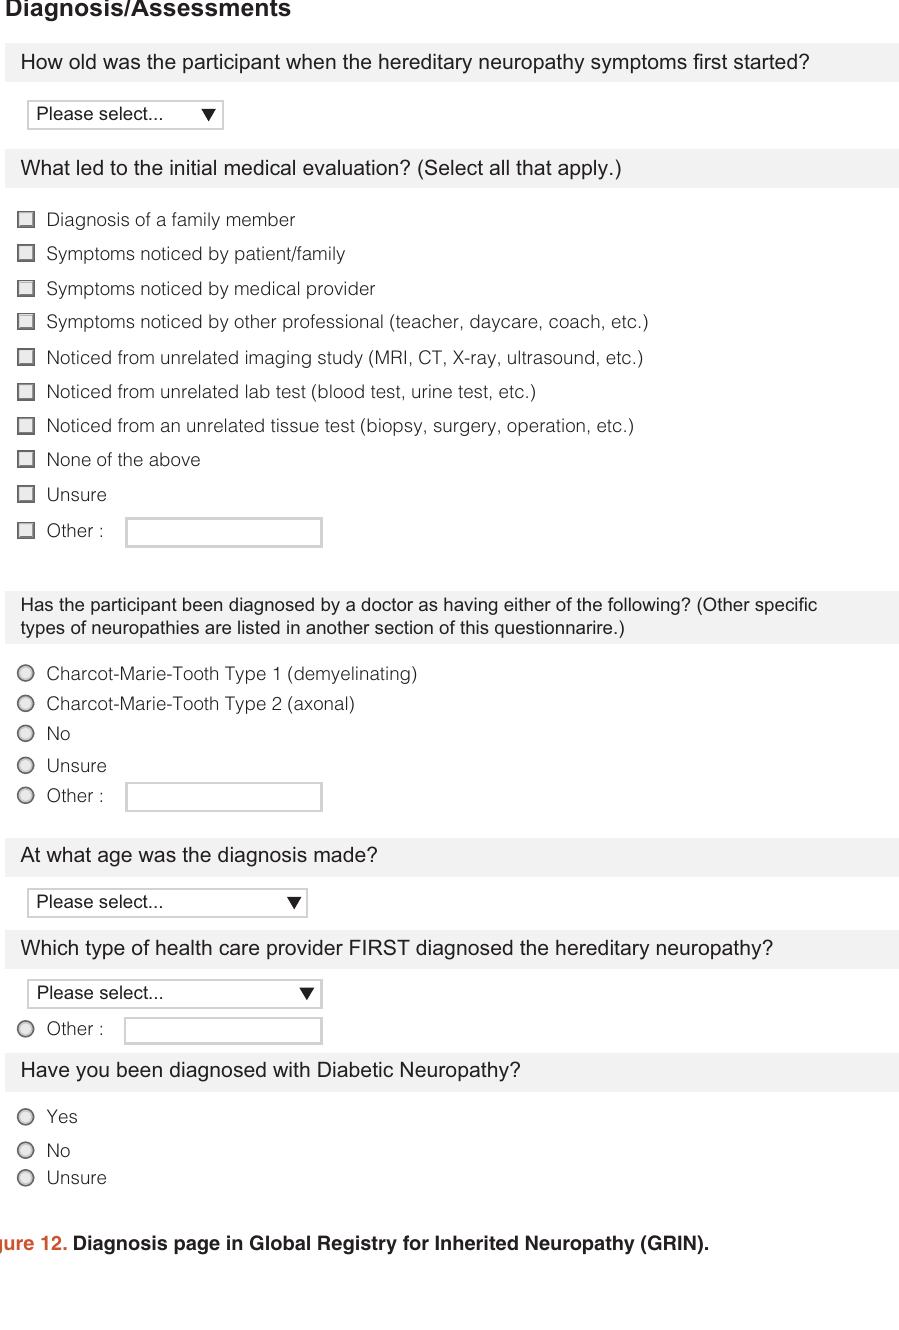
Supplemental Figure 12. Diagnosis page in Global Registry for Inherited Neuropathy (GRIN).